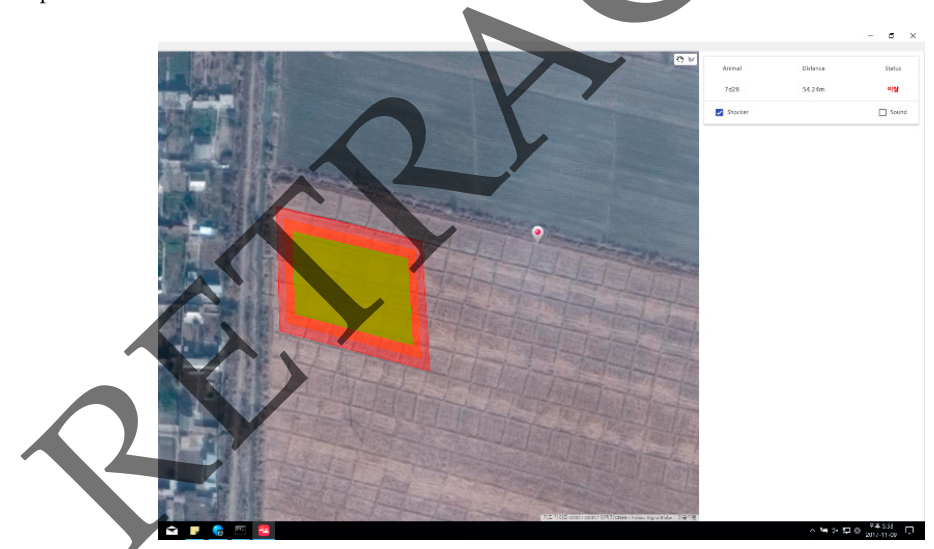
Figure 7. Virtual Fence GUI with an animal outside of the virtual fence.